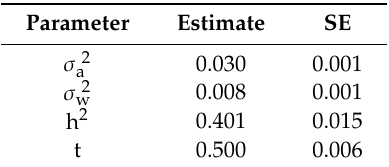
Table 2. Additive genetic variance ( σ 2 a ), cow permanent environmental variance ( σ 2 w ), heritability (h 2 ), and repeatability (t) of bovine milk total antioxidant activity.